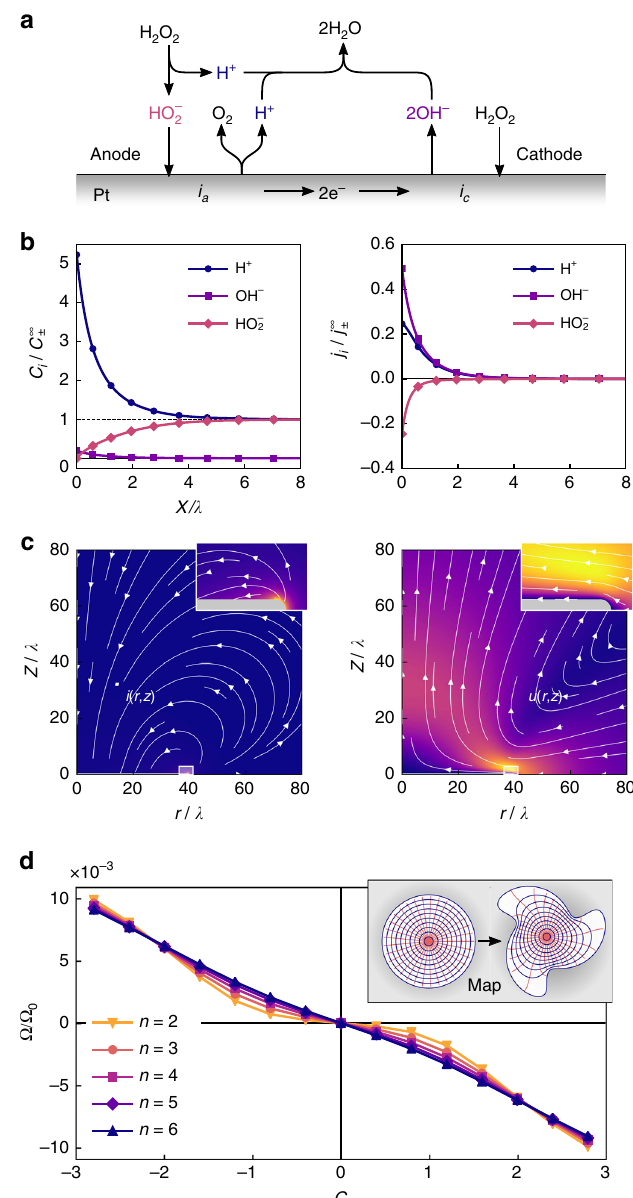
Fig. 4 Results of the self-electrophoretic propulsion model. a Kinetic mechanism for the electrocatalytic decomposition of H 2 O 2 over platinum. b Computed ion concentrations C i (left) and fl uxes j i (right) as a function of distance x from a planar Pt surface. Concentration is scaled by the bulk